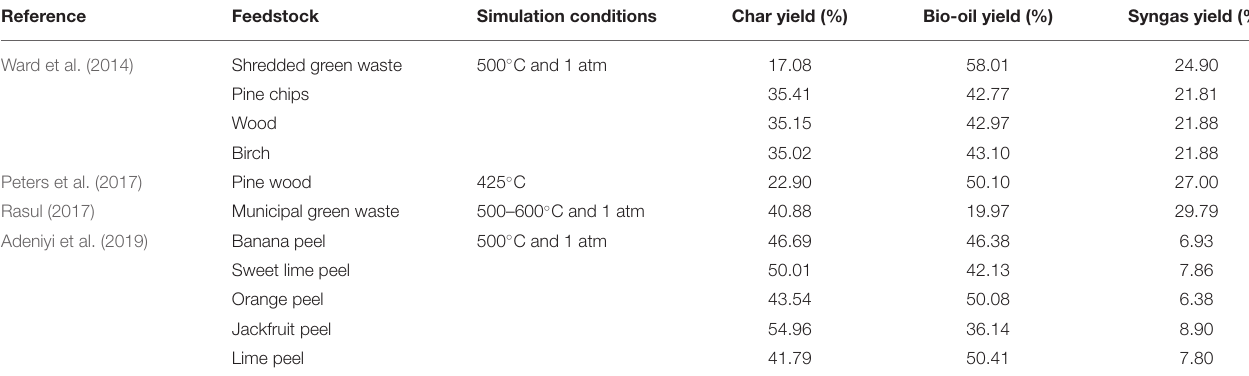
TABLE 5 | The simulation results of other works. Reference